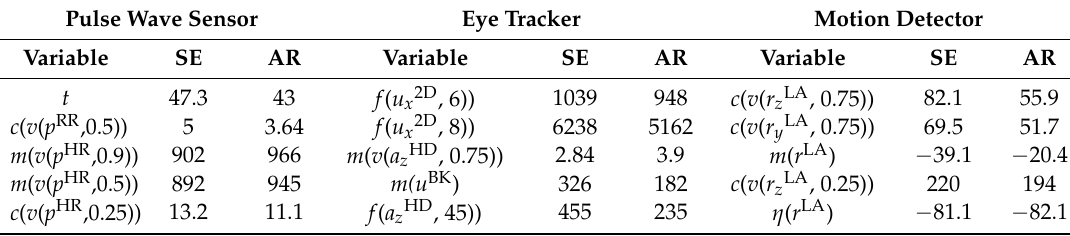
Table 6. Top five of the important variables for predicting the arousal in the generalized